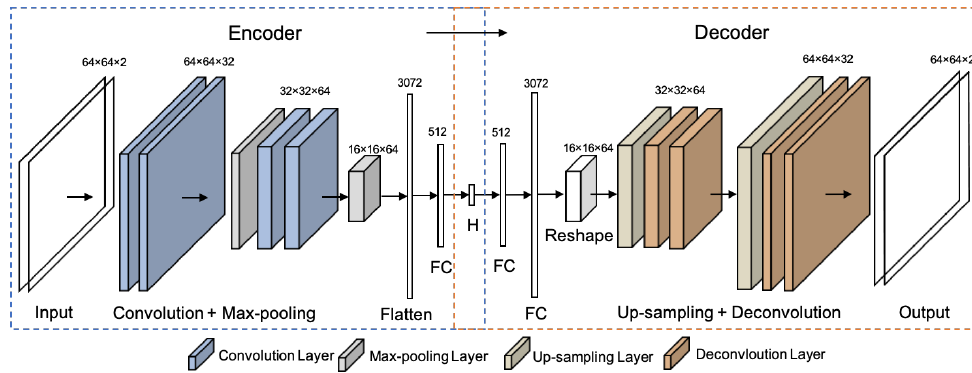
Figure 5. The structure of the proposed convolutional autoencoder (CAE) for traffic state representation.